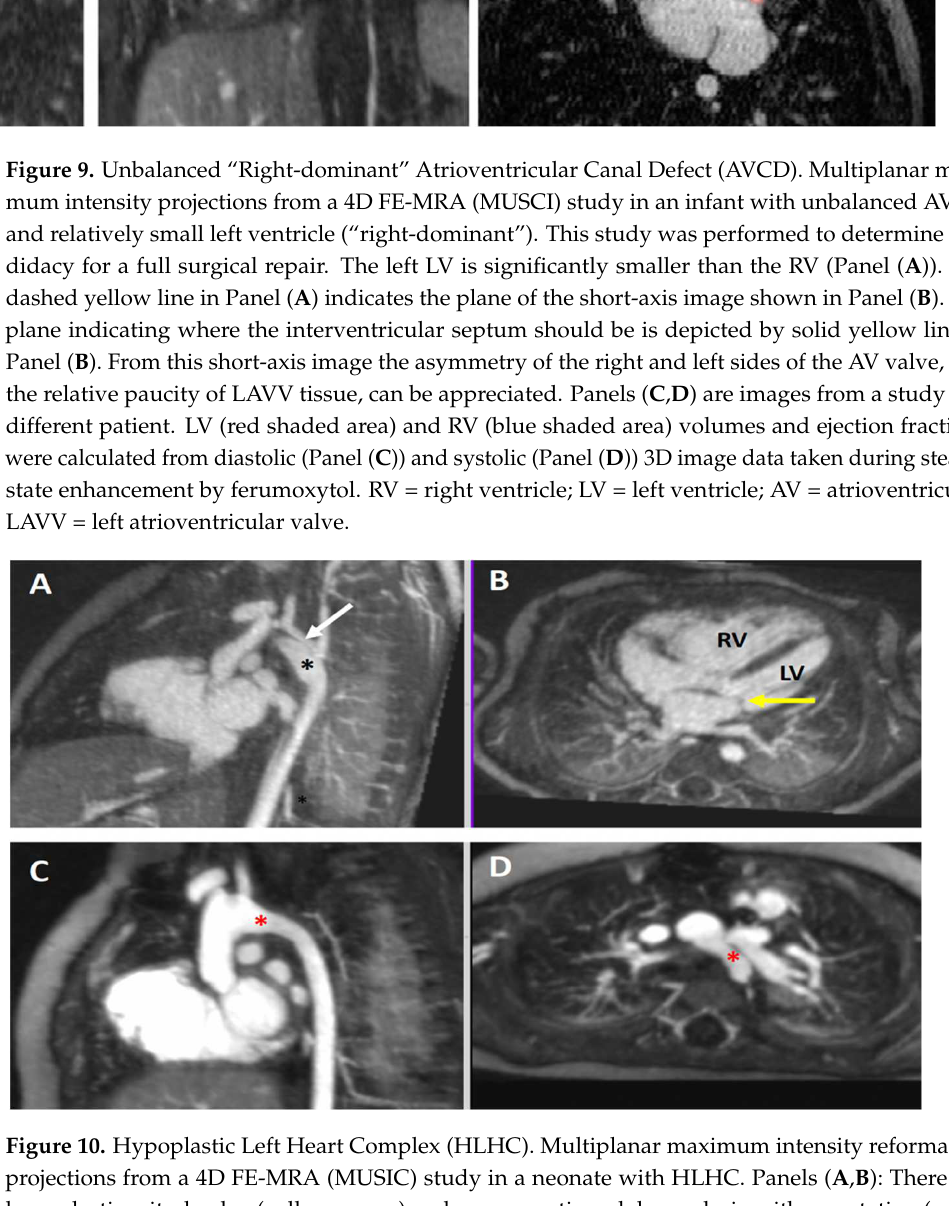
Figure 10. Hypoplastic Left Heart Complex (HLHC). Multiplanar maximum intensity reformatted projections from a 4D FE-MRA (MUSIC) study in a neonate with HLHC. Panels ( A , B ): There is a hypoplastic mitral valve (yellow arrow) and severe aortic arch hypoplasia with coarctation (white arrow). A large patent ductus arteriosus is also present (black asterisk). There is LV hypoplasia with relative enlargement of the RV. Panels ( C , D ): Postoperative images in the same patient using the same technique show a widely patient aortic arch after surgical repair (red asterisk). LV = left ventricle; RV = right ventricle.